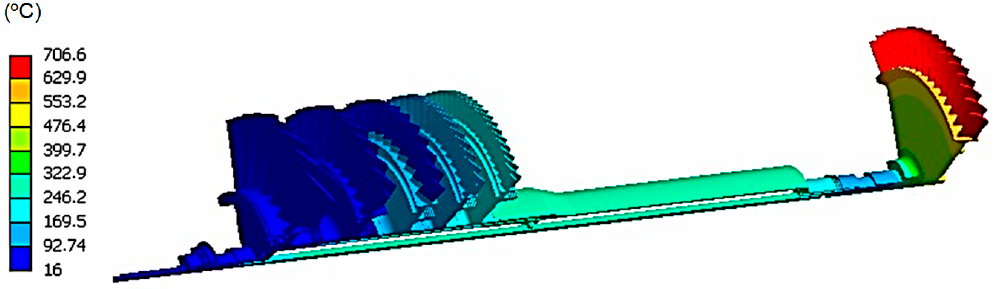
Figure 7. Temperature distribution over a one eighth section of the rotating assembly.